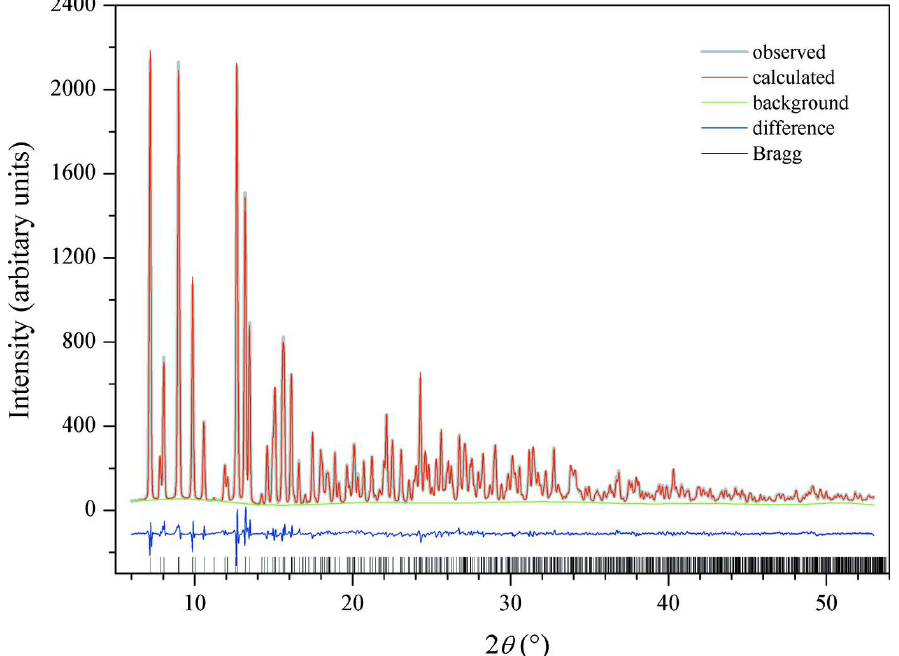
Figure 1 The observed, calculated, background and difference X-ray diffraction profile for natural mansfieldite. Bragg reflection positions are shown at the